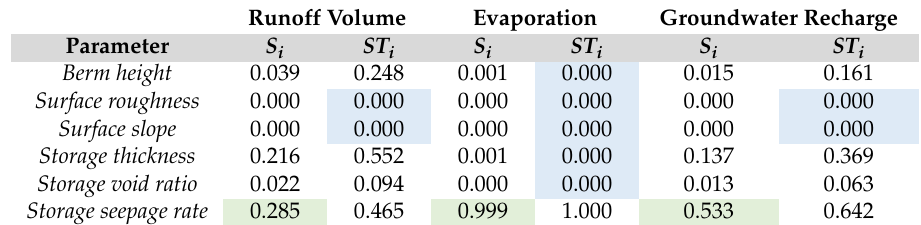
Table 3. Results of the long-term sensitivity analysis for the infiltration trench;